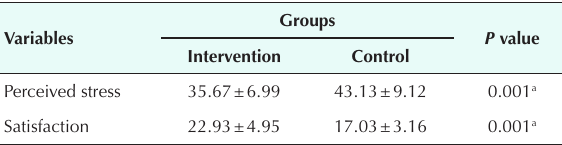
a The results of the independent-sample t